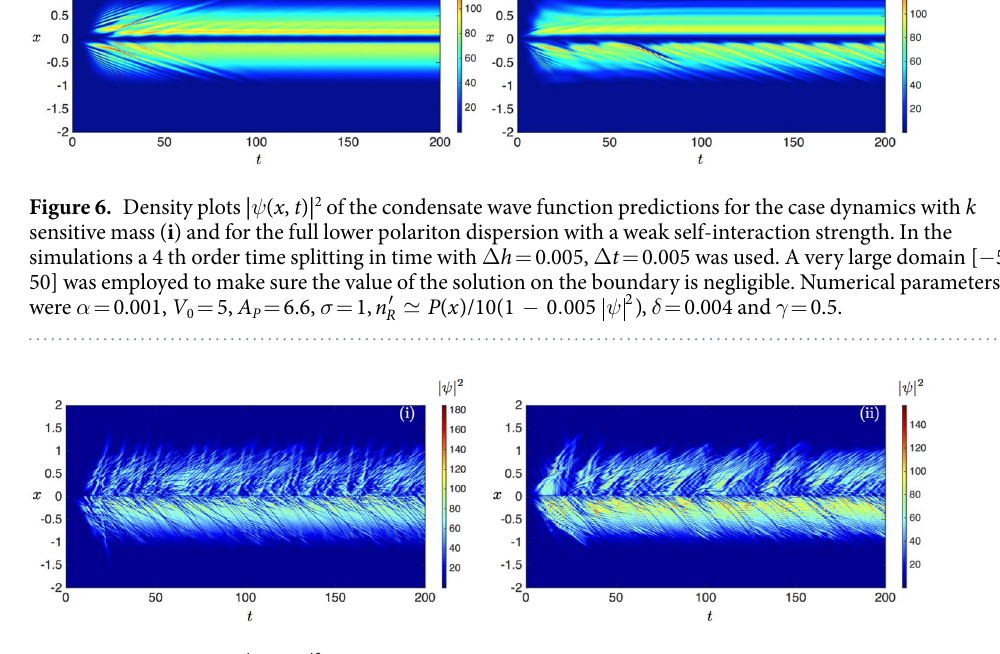
Figure 7. Density plots | ψ ( x , t )| 2 of the condensate wave function predictions for the kinetic energy of the effective mass model ( i ) and the general polariton dispersion ( ii ) with a stronger self-interaction strength which is 50 times larger than the one used for Fig.